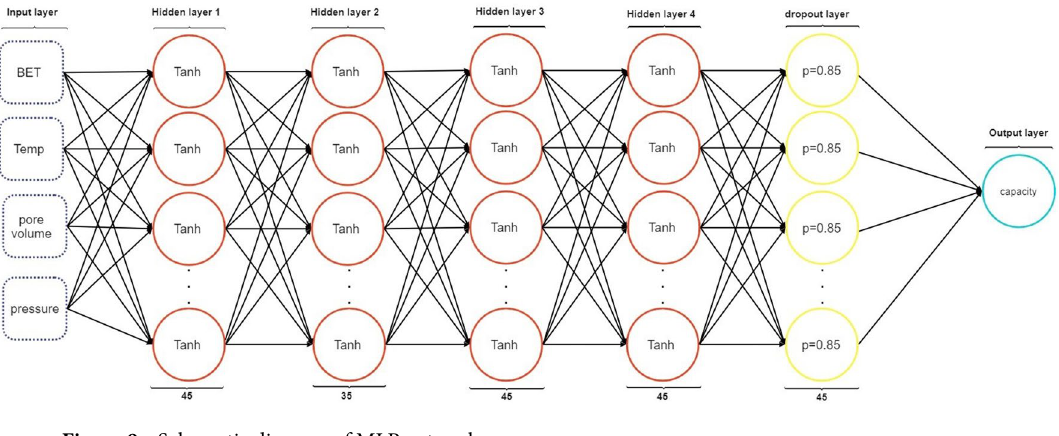
Figure 9. Schematic diagram of MLP